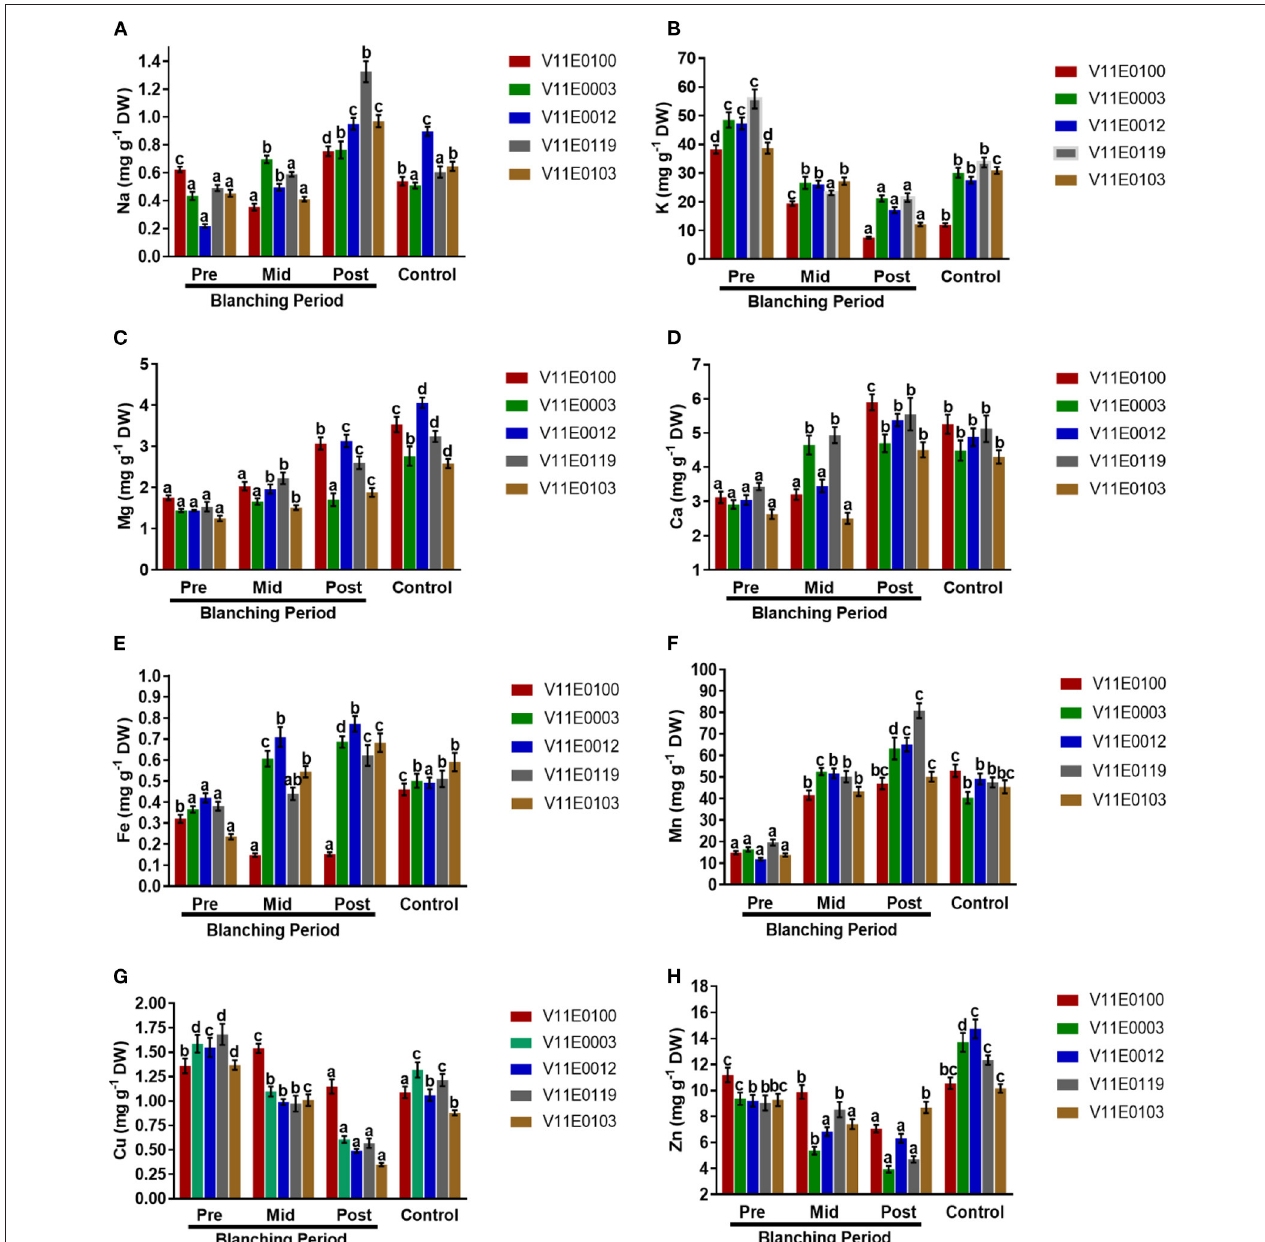
FIGURE 9 | Effect of blanching on the uptake of Minerals. (A) Na uptake, (B) K uptake, (C) Mg uptake, (D) Ca uptake, (E) Fe uptake, (F) Mn uptake, (G) Cu uptake, and (H) Zn uptake in the stem of five water dropwort cultivars. Four types of samples were analyzed; Pre-blanching, Mid-blanching (20 days), Post-blanching (40 days), and Control (grown under normal conditions). Different letters indicate a significant difference ( P < 0.05) among the treatments according to the Tukey test. Values are means ±